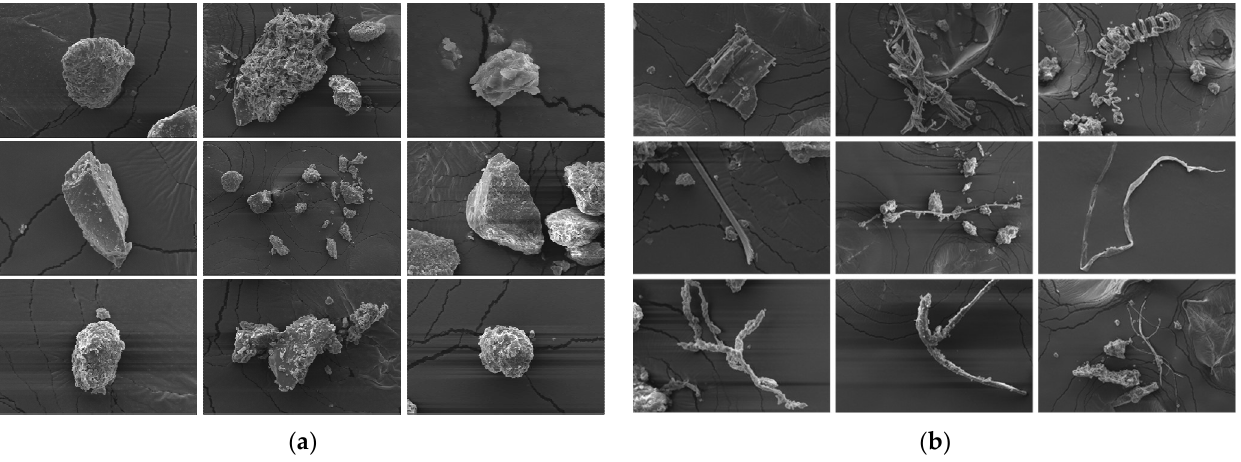
Figure 4. SEM images of the dust particles from the total amount of dust of a peanut whole-feed harvester: ( a ) Soil dust particles and ( b ) Fiber dust particles.